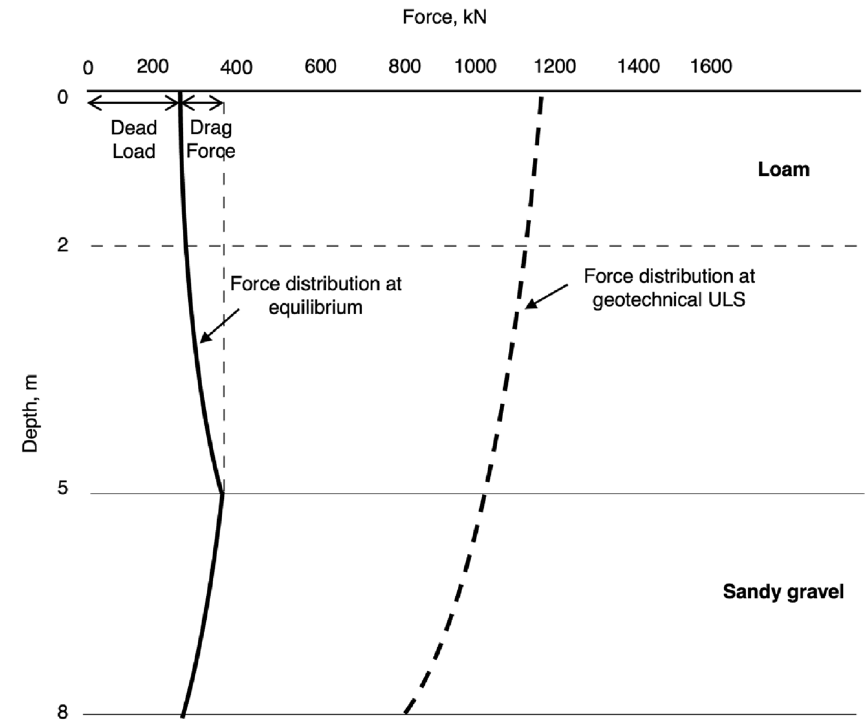
Fig. 2 Pile force distribution at equilibrium and geotechnical ULS for Case I